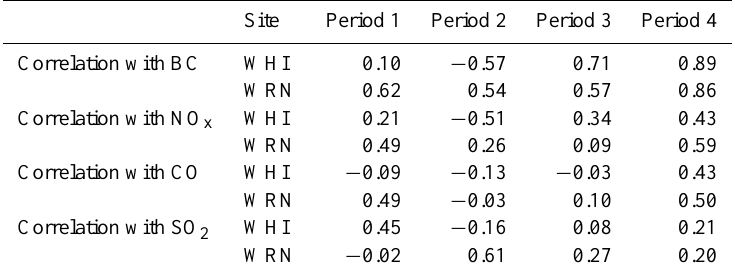
Table 4. Correlation coefficients between the integrated total particle number concentration from the SMPS with BC, NO x , and CO during each period for the two sites. The correlations are calculated for 24 h averages of each